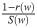
The amount of water that a WF wasp is expected to unload per interaction (normalized) when the common stomach water level is w (the amount of water is given as a fraction of one crop load).This is the rate at which water is transferred into the common stomach per interaction: 1−r(w)S(w).